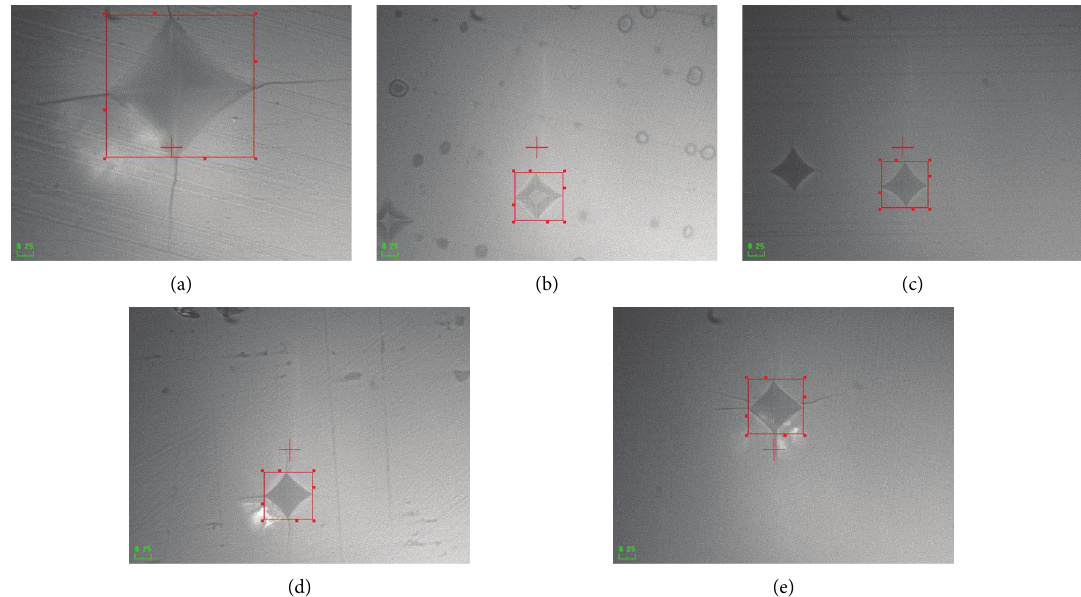
Figure 5: Vickers impression on lithium disilicate ceramics: (a) G1, Celtra Duo crystallized; (b) G2, Celtra Duo noncrystallized; (c) G3, e.max CAD crystallized; (d) G4, Vita Suprinity; (e) G4, Rosetta SM crystallized.